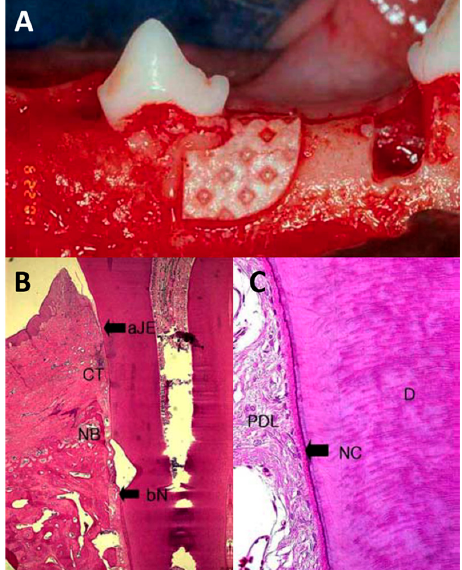
Figure 4. Photos of PLGA membranes for the treatment of intrabony defects in dogs. Adapted from [49] with permission. ( A ) shows the one-wall intrabony defects treated with PLGA membranes. ( B ) shows the defect treated with PLGA membrane demonstrated dense connective tissue formation, a moderate increase of new bone and new cementum, and ( C ) shows the perpendicular arrangement of periodontal ligament fibers in the areas of new bone and new cementum regeneration.